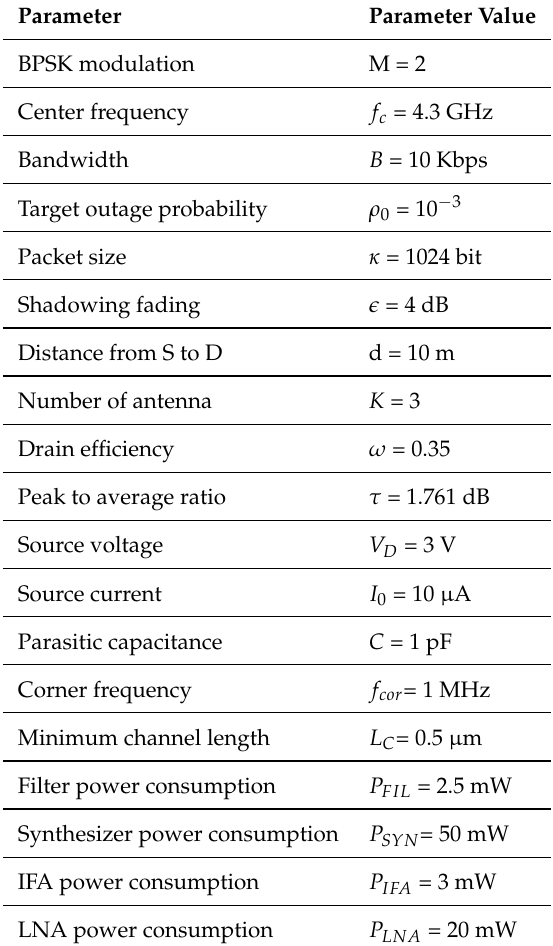
Table 2. Parameter